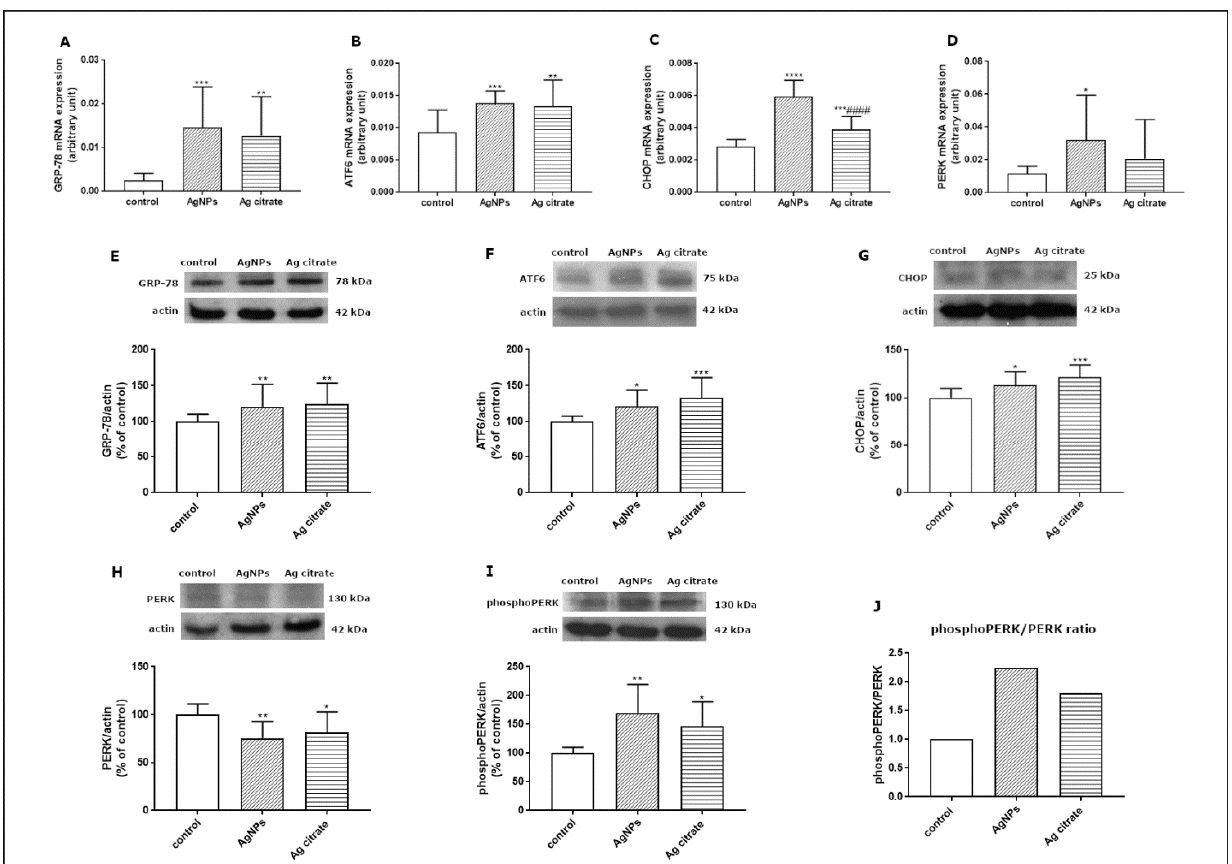
Figure 9. Expression of selected UPR-related proteins: GRP78 mRNA ( A ), ATF6 mRNA ( B ), CHOP mRNA ( C ), and PERK mRNA ( D ) in the brain of control, AgNP-, and Ag + -exposed rats. The mRNA levels were determined by qPCR and normalized against actin. The graph shows the results as mean ± SD from arbitrary units obtained from four independent experiments performed using 4 distinct rats per group. * p < 0.05, ** p < 0.01, *** p < 0.001, **** p < 0.0001 significantly different vs. control, #### p < 0.0001 significantly different vs. AgNPs (ANOVA with post hoc Tuckey’s test). Relative expression of GRP78 ( E ), ATF6 protein ( F ), CHOP protein ( G ), PERK protein ( H ), and phosphoPERK ( I ) protein in the brain of control, AgNP-, and Ag+-treated rats. The comparative ratio of phosphoPERK to PERK protein ( J ). Representative immunoblots and graphs illustrating the mean ± SD of densitometric measurements of five independent immunoblots performed using four distinct animals per group. The relative density was measured against β -actin as an internal standard and expressed as a percentage of control. * p < 0.05, ** p < 0.01, *** p < 0.001 significantly different vs. control (ANOVA with post hoc Tuckey’s